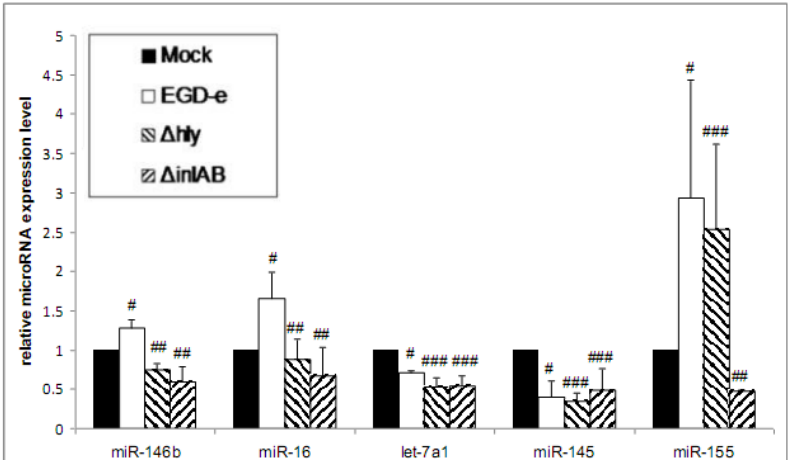
Figure 1. Measurement of miRNA candidates in infected Caco-2 cells compared to uninfected Caco-2 cells at 1 h post infection with L. monocytogenes EGD-e wild-type, Δ hly or Δ inl AB. Error bars indicate standard deviations. # significant difference compared to control ( p -value < 0.05). ## significant difference compared with wild-type infection ( p -value < 0.05), ### no significant difference compared with wild-type infection ( p -value >